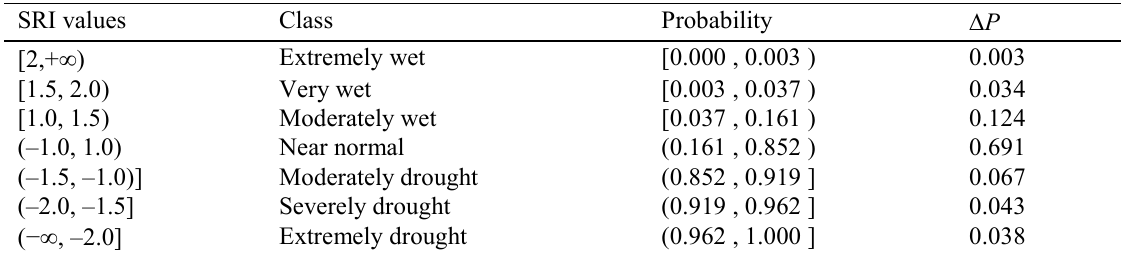
Table 1 Wet and drought period classification based on SRI